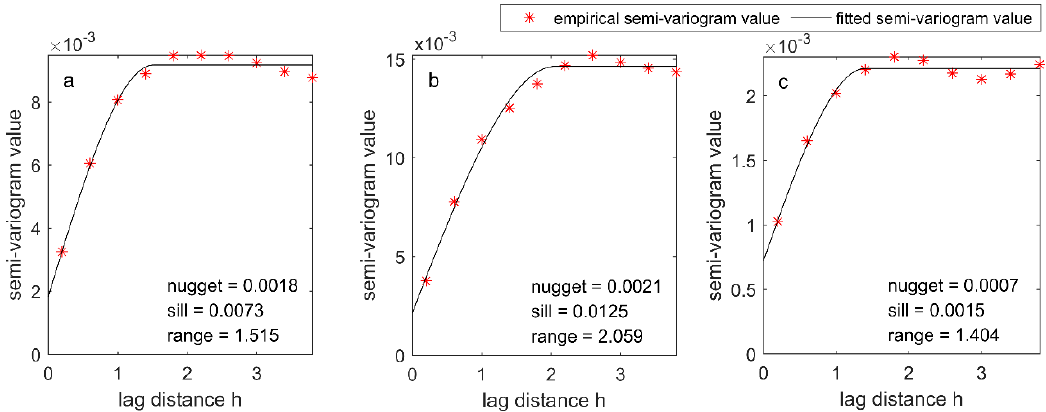
Figure 5. An example of fitted semi-variogram function with spherical model for ( a ) DB AOD residuals, ( b ) DT_DB_Combined AOD residuals, and ( c ) MISR AOD residuals in 2017-10-30.